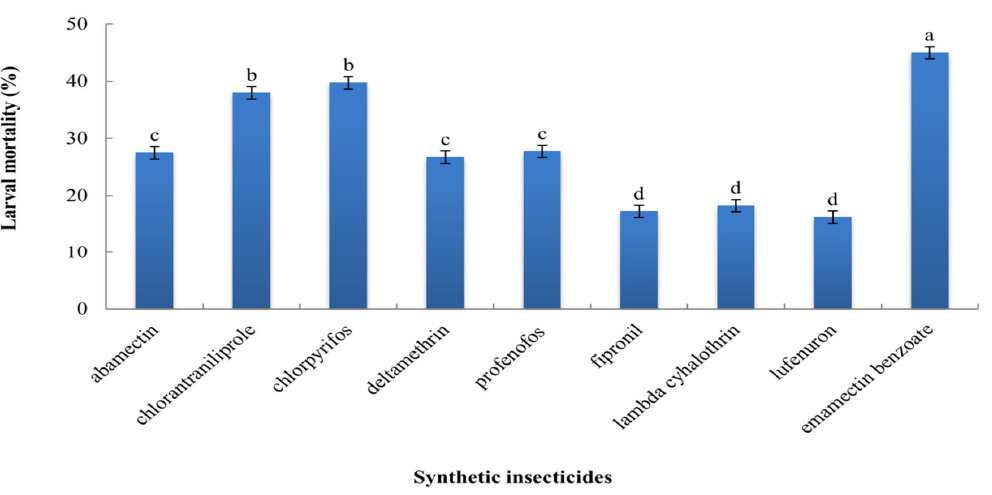
Figure 3. Percent mortality (mean ± SE; n = 10) of 3rd instar larvae of the fall armyworm Spodoptera frugiperda by different synthetic insecticides. Letters above the bars indicate significant differences among the treatments (one ‐ way ANOVA; HSD at α = 0.05).